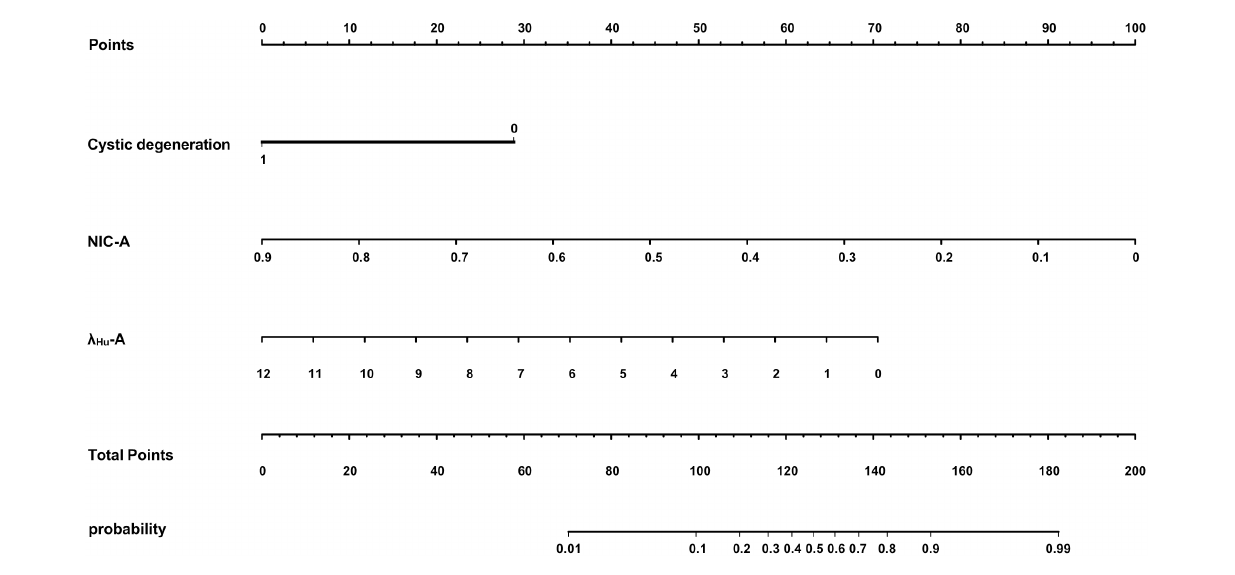
FIGURE 2 A DLCT-based nomogram was plotted combining independent radiological features with DLCT quantitative parameters in the training